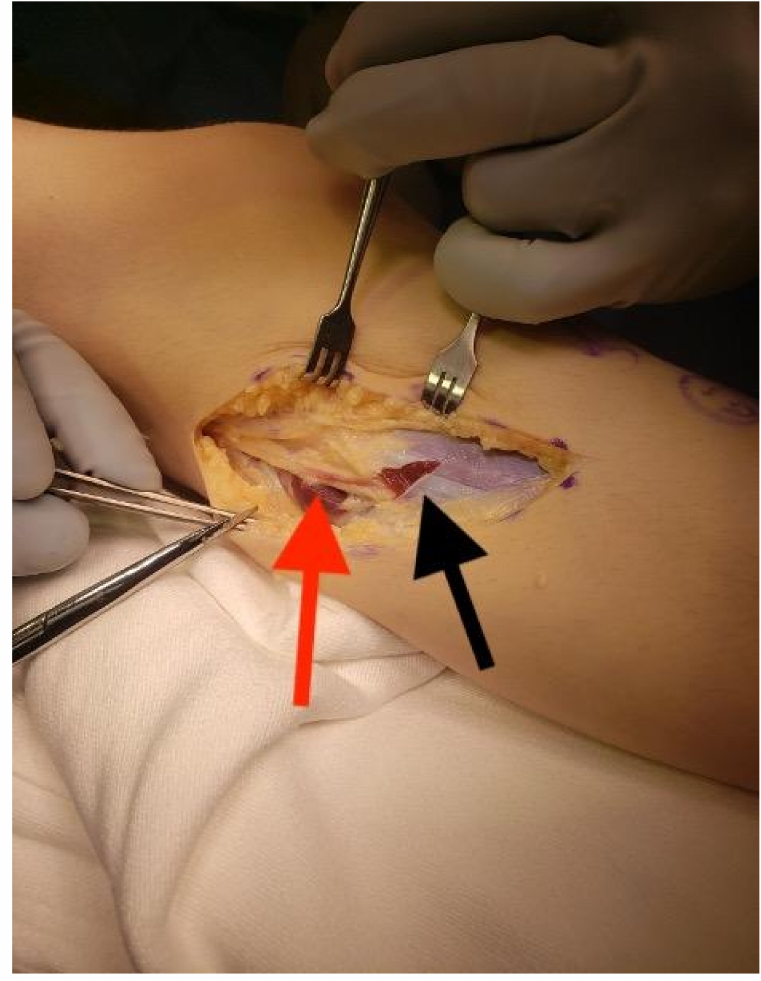
Figure 4. Peroneal nerve released (red arrow) as is crosses the fibula and enters the lateral com- partment; note the start of the transverse fasciotomy of the lateral compartment that will continue through the anterior compartment (black